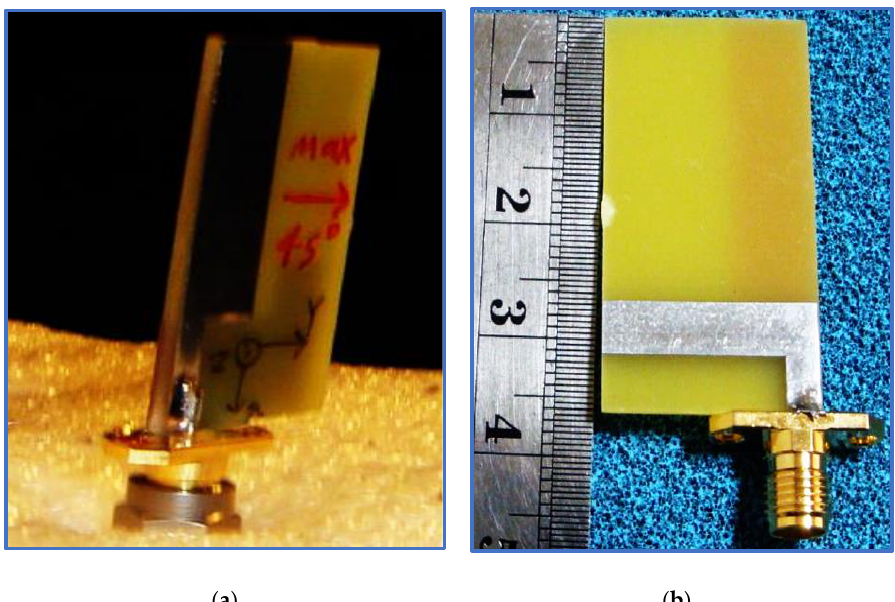
Figure 29. A prototype of the asymmetric fed rectangular monopole antenna: ( a ) side view; ( b ) back view [142].